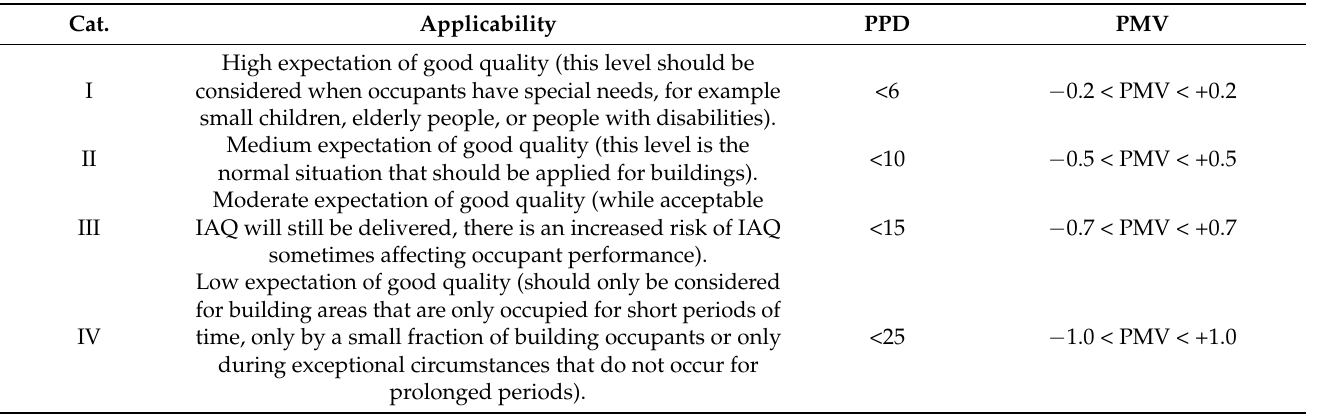
Table 1. Indoor Environmental Quality categories for thermal comfort requirements for residential building and living spaces with sedentary activities